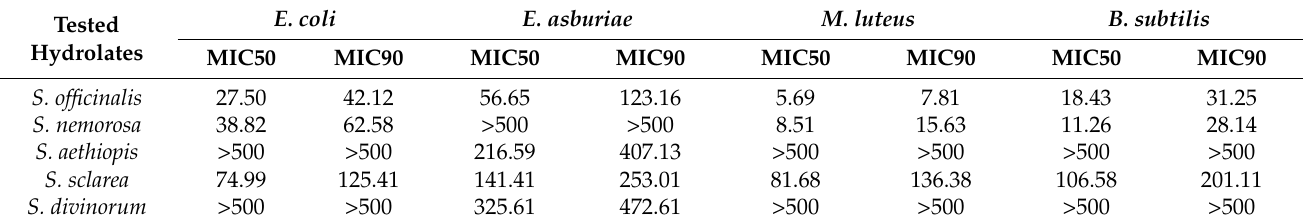
Table 2. The minimum inhibitory concentration (MIC) of the tested hydrolates expressed in µ L/mL.